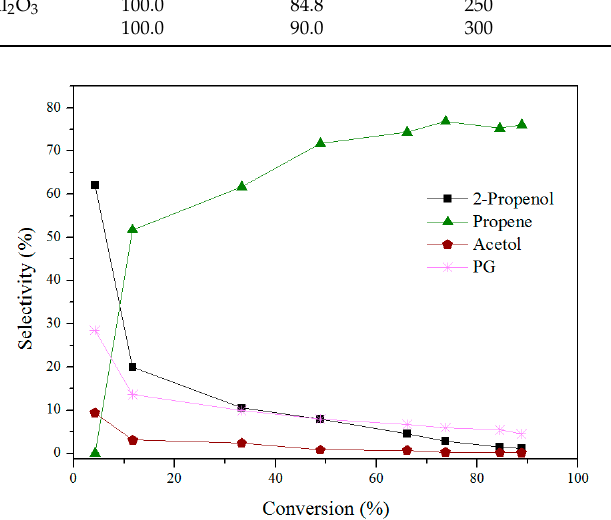
Figure 8. Effect of reaction time on selectivity over the Fe–Mo/BC_A catalyst (H 2 pressure: 8.0 MPa, Figure (cid:561) 8. (cid:561) Effect (cid:561) of (cid:561) reaction (cid:561) time (cid:561) on (cid:561) selectivity (cid:561) over (cid:561) the (cid:561) Fe–Mo/BC_A (cid:561) catalyst (cid:561) (H 2 (cid:561) pressure: (cid:561) 8.0 (cid:561) MPa, (cid:561) temperature: 300 ◦ C). Reproduced from [90]. Copyright 2015, Royal Society of temperature: (cid:561) 300 (cid:561) °C). (cid:561) Reproduced (cid:561) from (cid:561) [90]. (cid:561) Copyright (cid:561) 2015, (cid:561) Royal (cid:561) Society (cid:561) of (cid:561) Chemistry. (cid:561)